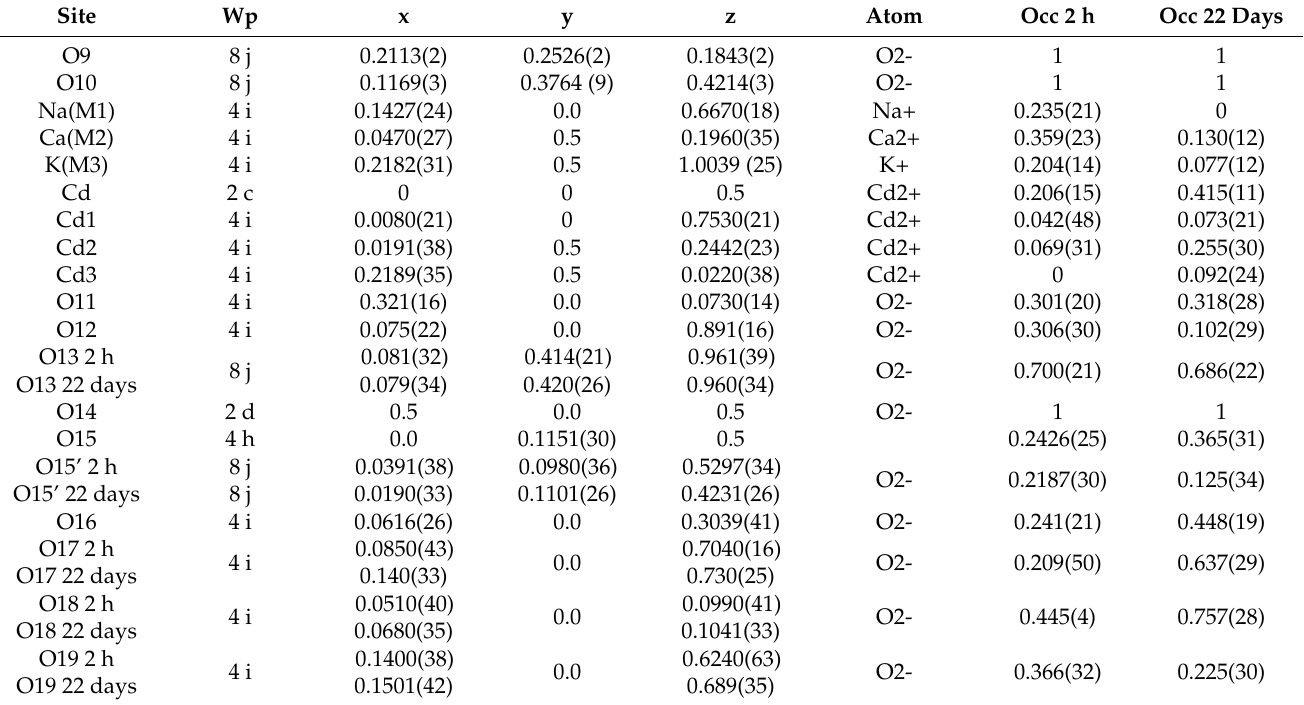
Table 5. Interatomic distances of the extra-framework cations and H 2 O molecules of samples Cd-clinoptilolite (90 ◦